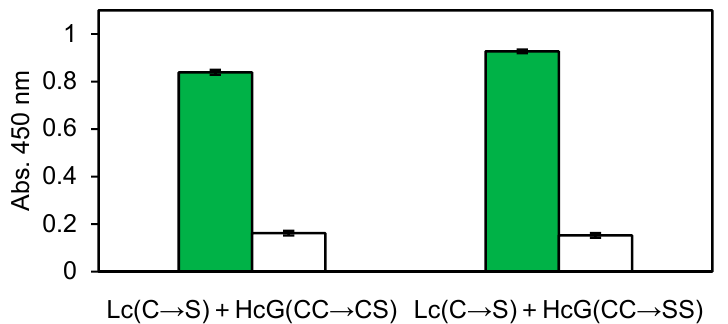
Figure 4. ELISA result of the refolded 14 G mutated clones for nontoxic VT2. Green: Antigen, White: BSA. Error bars indicate standard deviations.